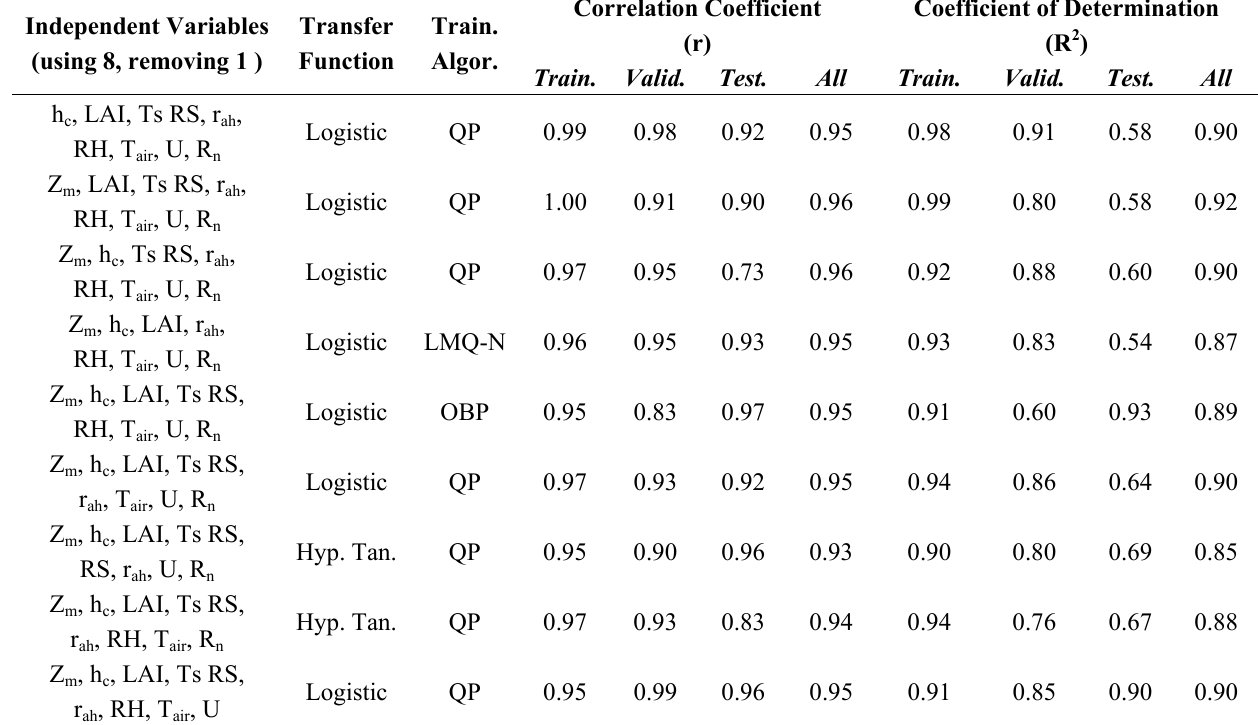
Table 3. Performance of ANN using combinations of eight independent variables. Independent